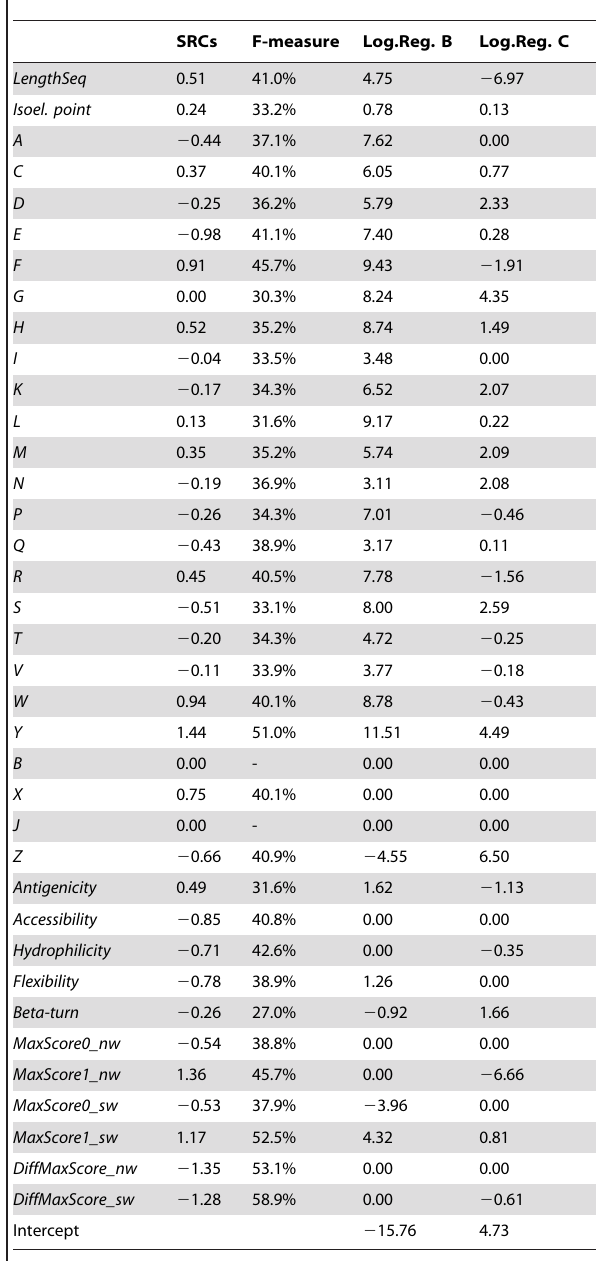
Table 2. The impact on the predictive performance of the features and the coefficients of the two best